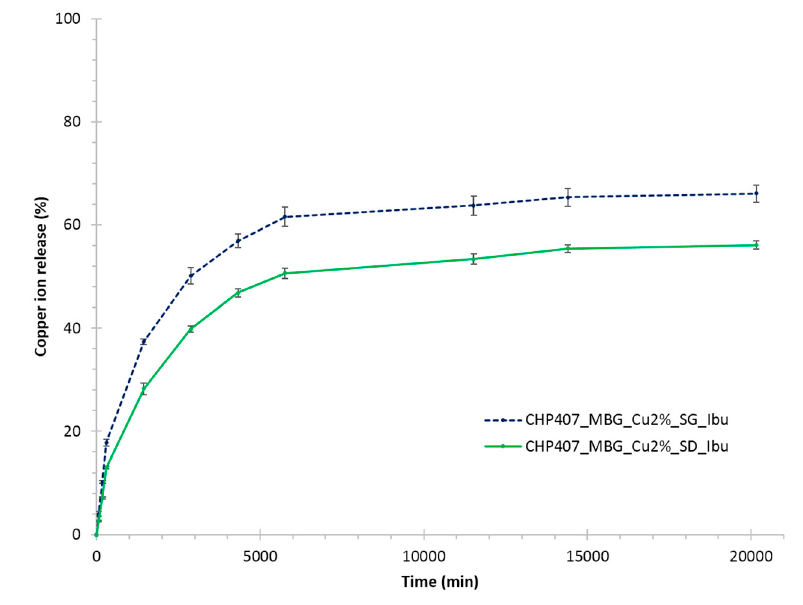
Figure 8. Copper ion release (%) profile from CHP407_MBG_Cu2%_SG_Ibu and CHP407_MBG_Cu2%_SD_Ibu